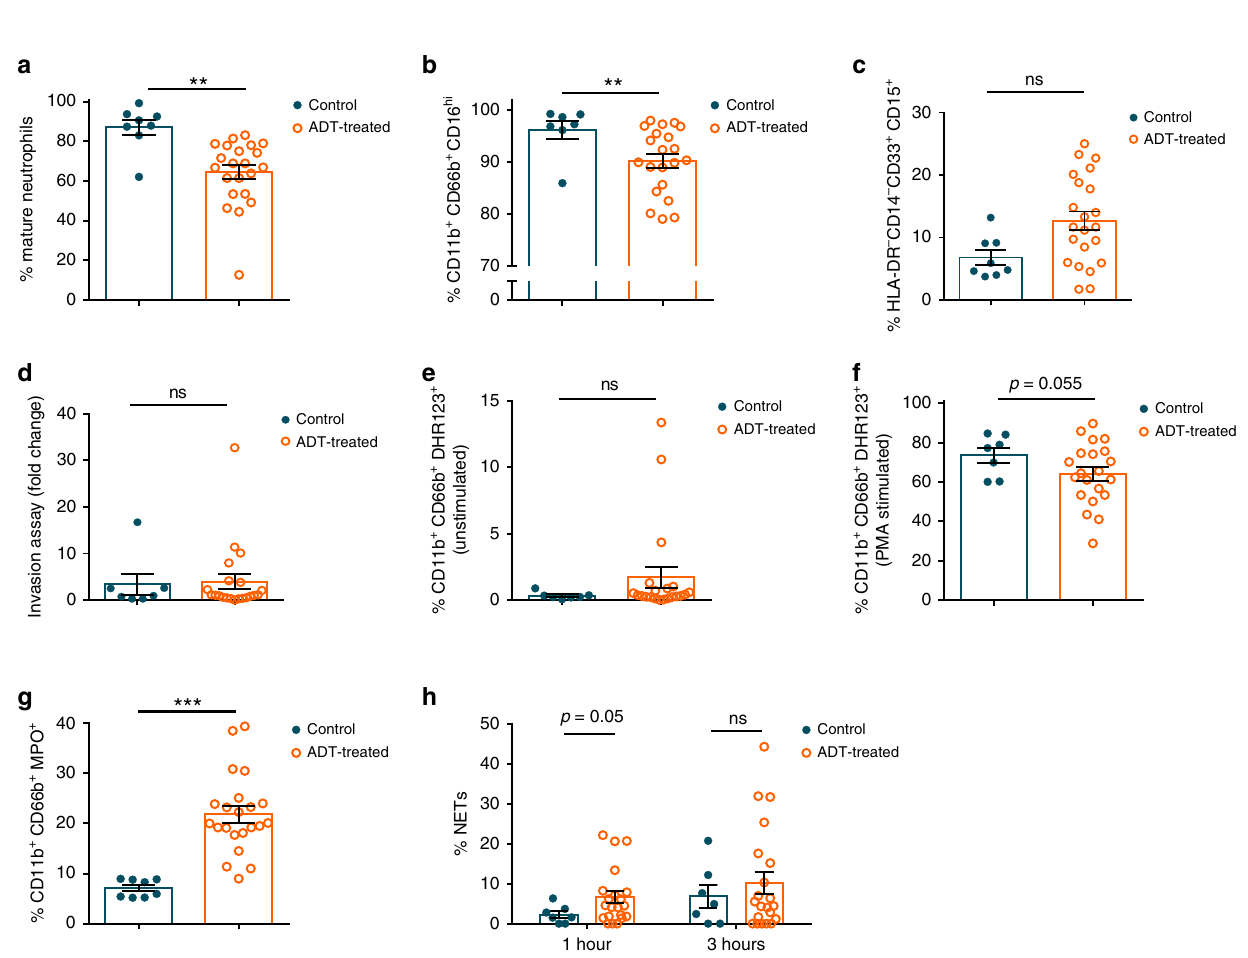
Fig. 5 Analysis of neutrophils from control or androgen deprivation therapy (ADT) treated patients. a Percent of circulating neutrophils from